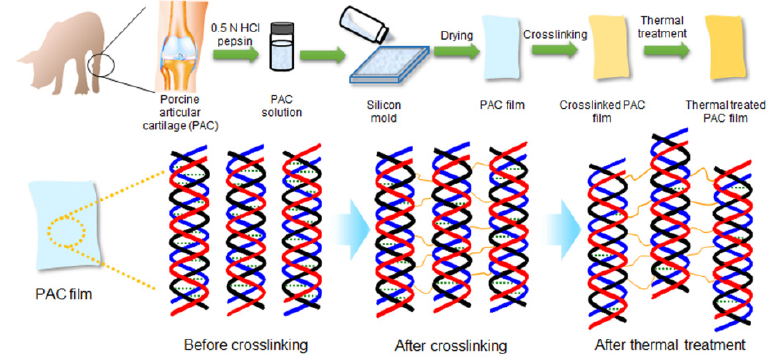
Figure 1. Schematic diagram for the preparation of UnC x ‐ PAC films and thermal ‐ treated C x ‐ PAC films.